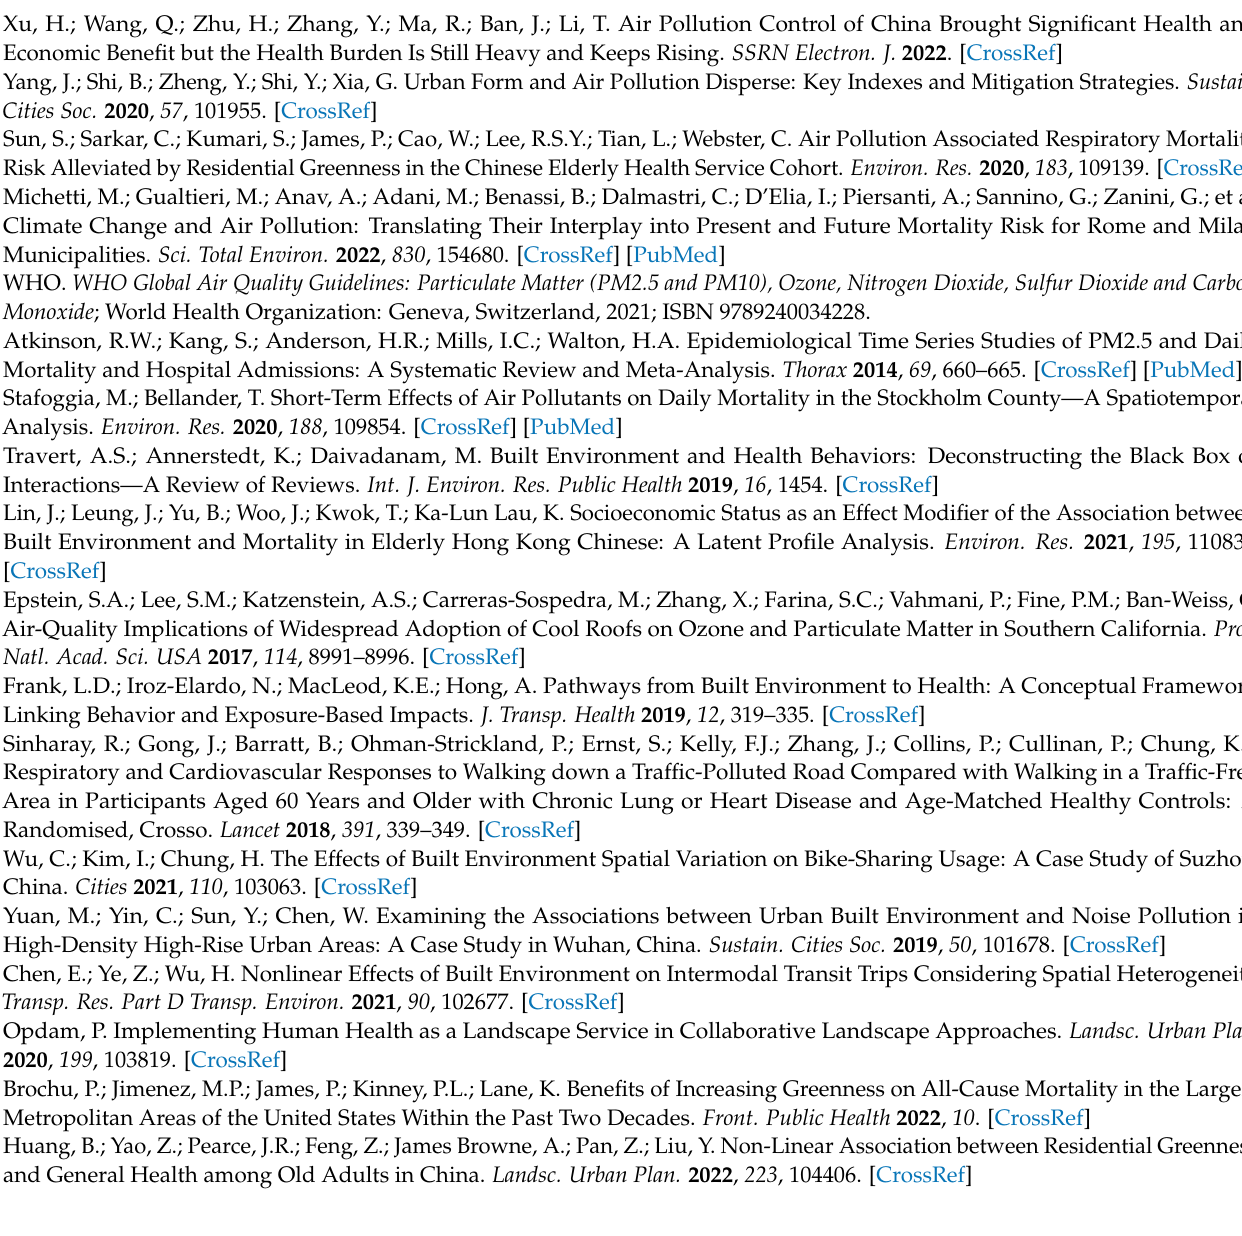
percentage of H-L type grids corresponding to Figure S1; Table S5: The percentage of not significant type grids corresponding to Figure